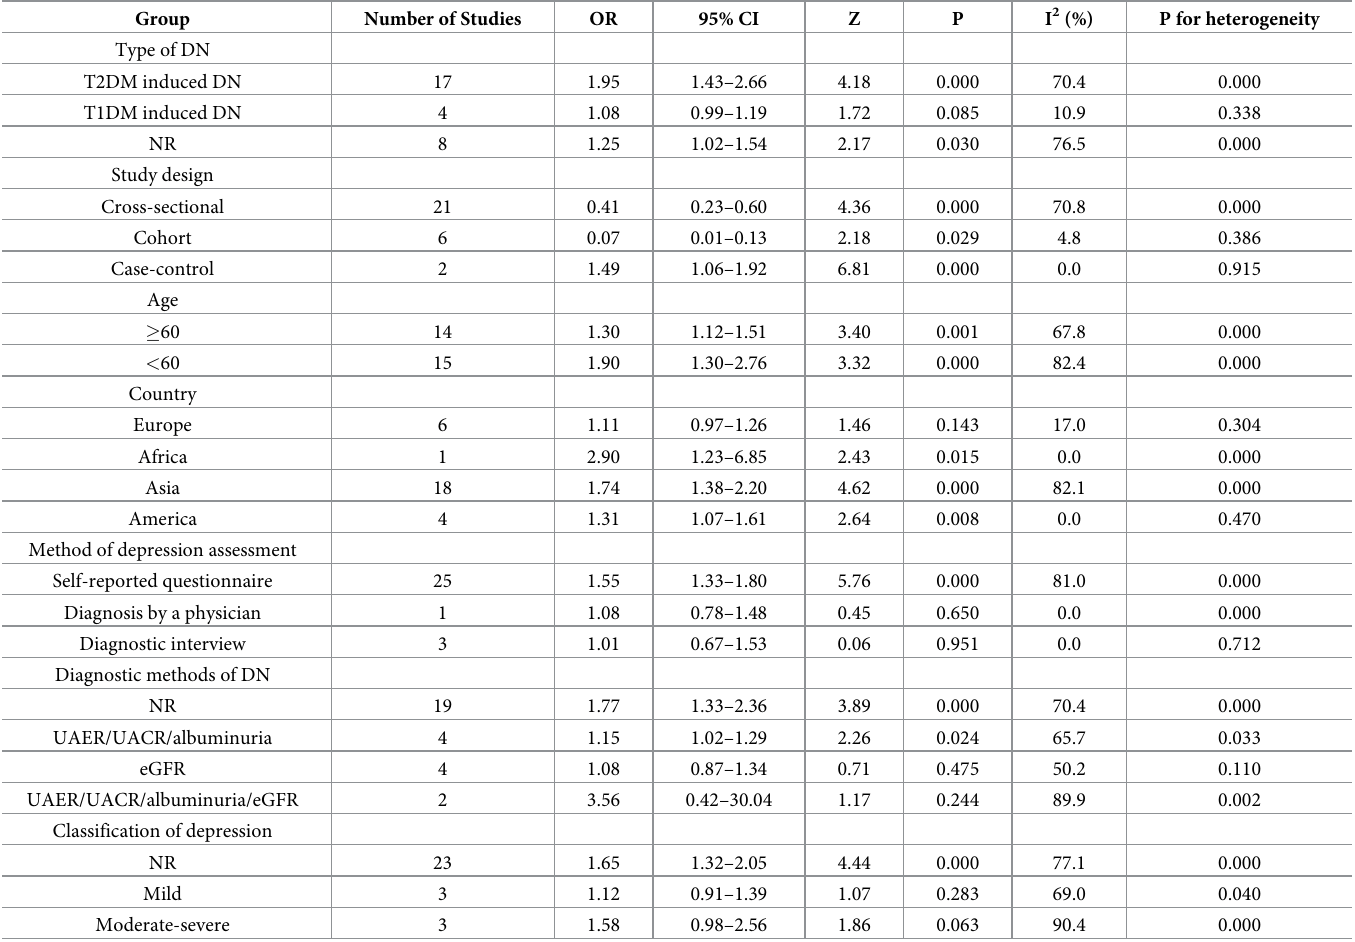
Fig 2. Forest plot of depression and diabetic nephropathy A: diabetic nephropathy predicting incident depression. B: depression predicting incident diabetic nephropathy.